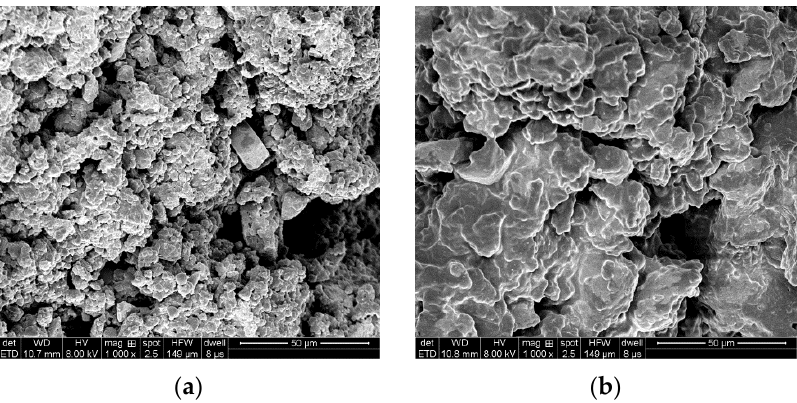
Figure 4. SEM images of crumb rubbers and plasticized crumb rubbers. ( a ) Crumb rubbers; ( b ) Figure4. SEMimagesofcrumbrubbersandplasticizedcrumbrubbers. ( a )Crumbrubbers; ( b )plasticized plasticized crumb rubbers. crumb